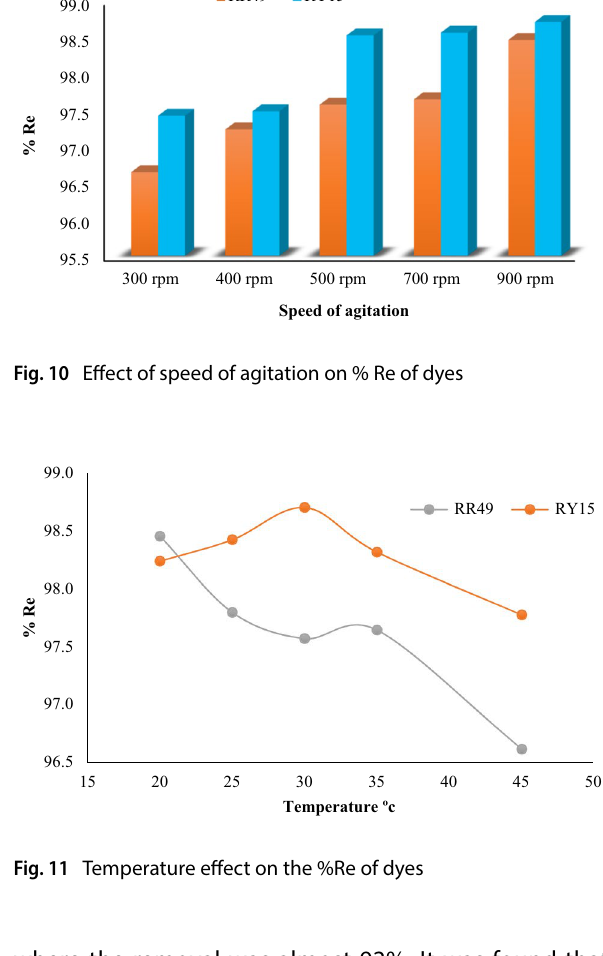
Fig. 11 Temperature effect on the %Re of dyes